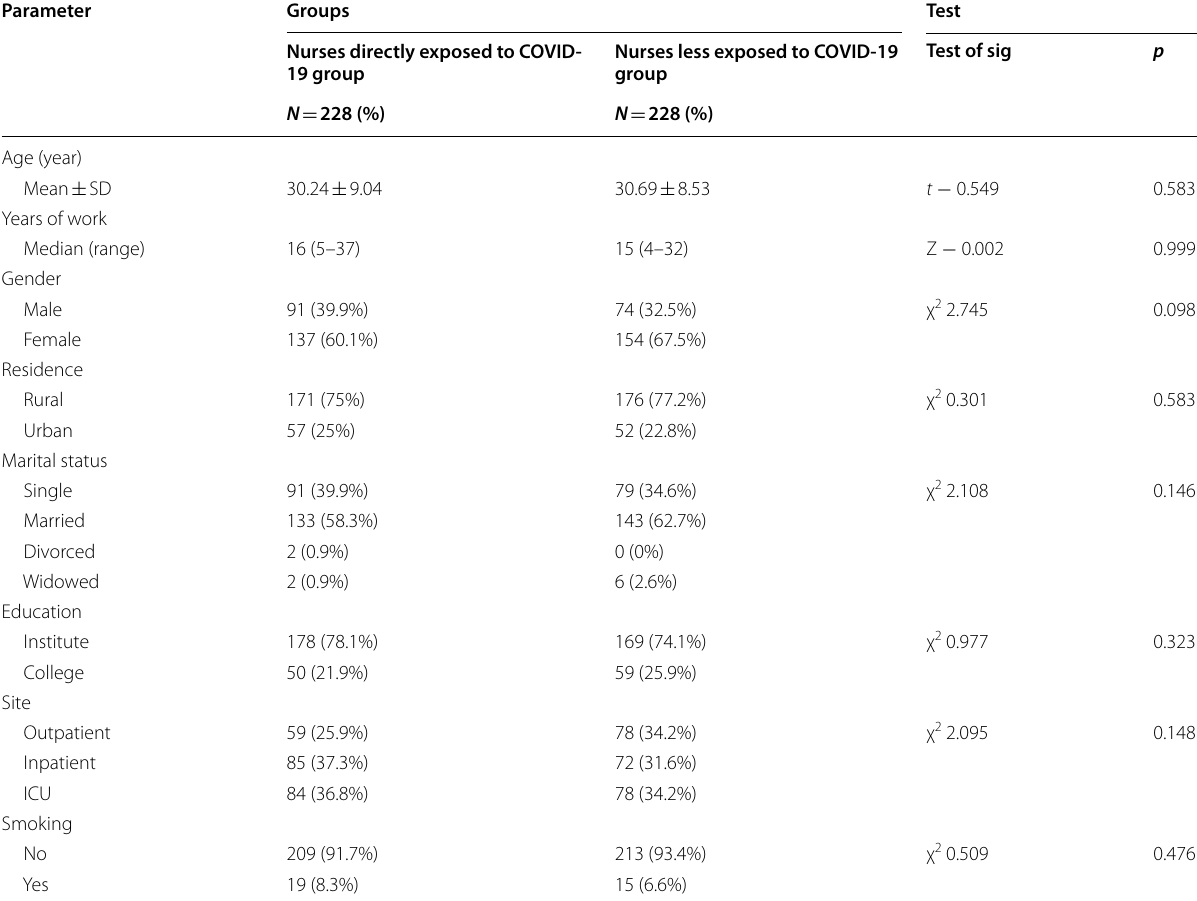
Table 1 Comparison between the studied groups regarding demographic data and smoking